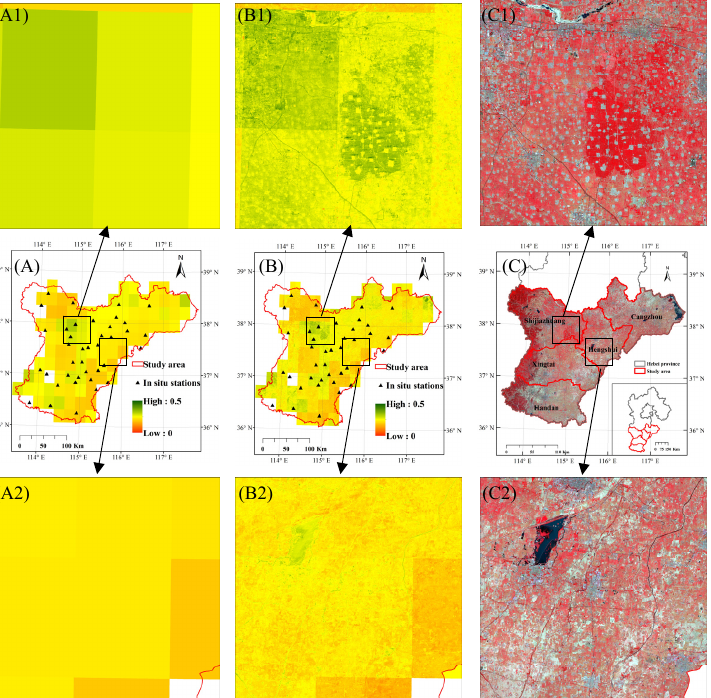
Figure 5. Spatial comparisons of the original CCI SM image ( A ), the downscaled CCI SM image ( B ) on 1 June, and the NIR-red-green composite of a GF image taken on 3 June ( C ) over the study area. The partial magnifications ( A1 – C1 ) showed the details of a small area of high SM values. The partial magnifications ( A2 – C2 ) showed the details of a small area of low SM values.